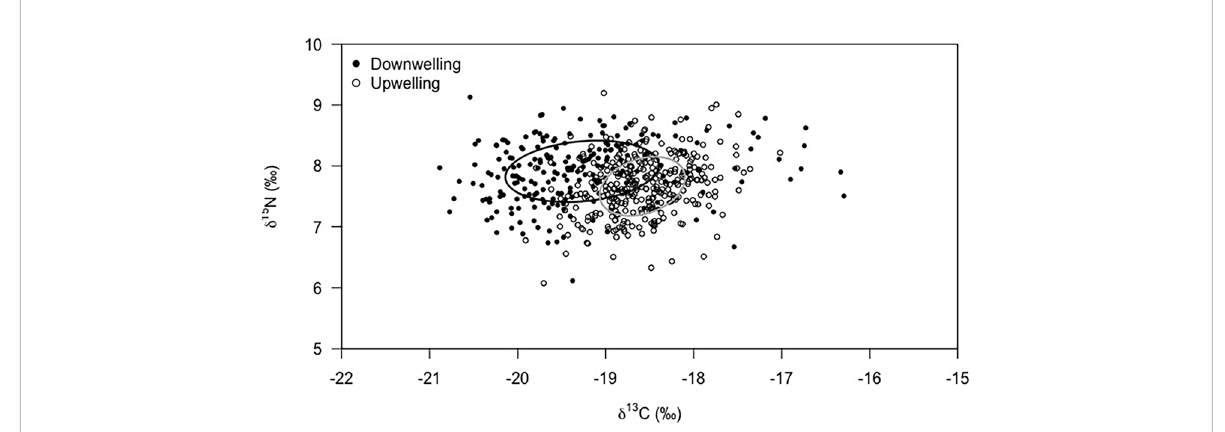
FIGURE 5 Isotopic niche area based on stable isotopes ( d 13 C and d 15 N) of Carcinus maenas megalopae collected during downwelling ( n = 226) and upwelling ( n = 307) conditions. The standard Bayesian Ellipse areas were signi fi cantly different between supply events (MANOVA, p <